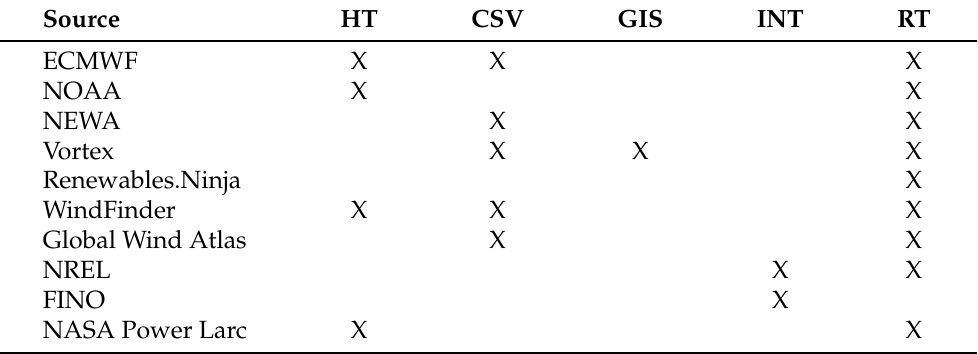
Table 8. Summary of the main improvements available to be implemented.